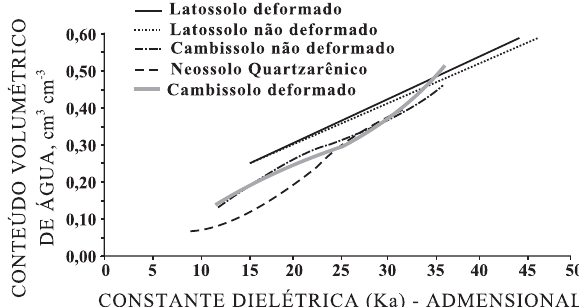
Figura 1. Curvas de calibração para obtenção do conteúdo de água no solo em função da constante dielétrica do solo para os diferentes tipos de solo com estruturas deformadas e não deformadas.